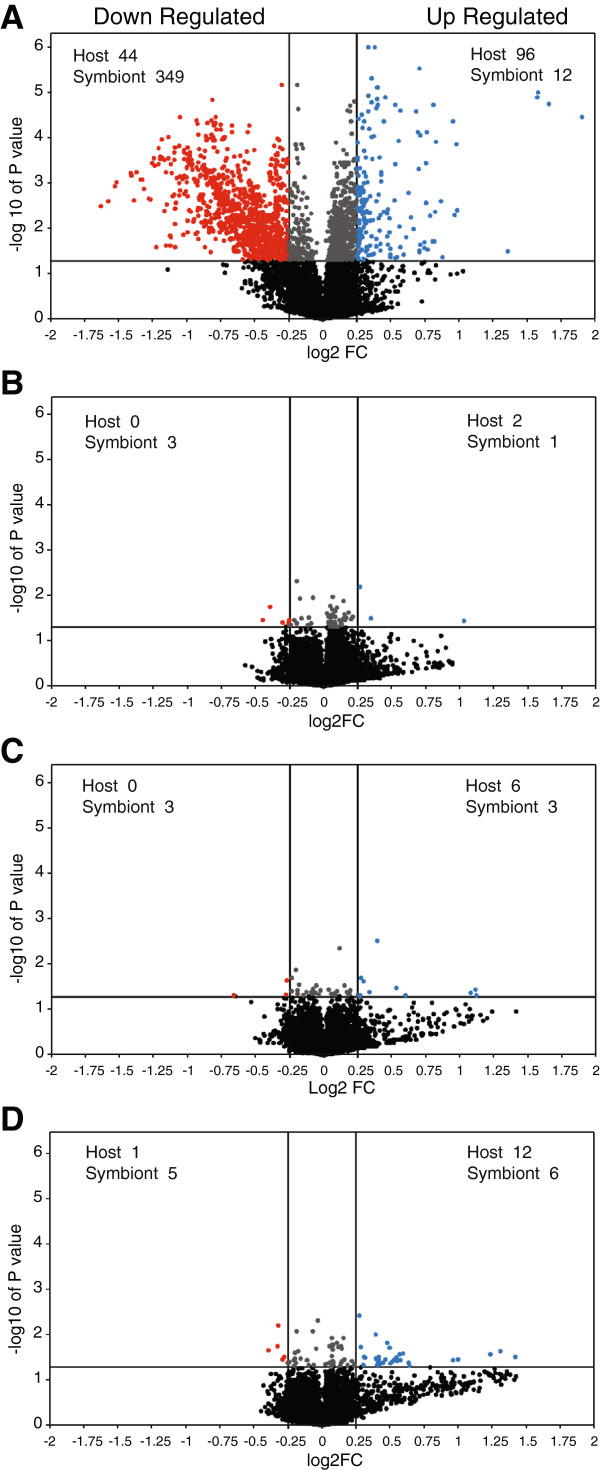
Volcano plots illustrating microarray results. Shown are numbers
of significantly (P <0.05) upregulated (blue;
≥1.19-fold) and downregulated (red; ≤0.84-fold) microarray
positions from four treatments that included juvenile hormone
(A), soldier head extract (B), live reproductives
(C) and live soldiers (D). The fold ratios on the
x-axis represent the ratio of EST abundance for each of the four
treatments relative to untreated controls. The numbers of contigs formed
from ESTs of host or symbiont origin are given in each panel.